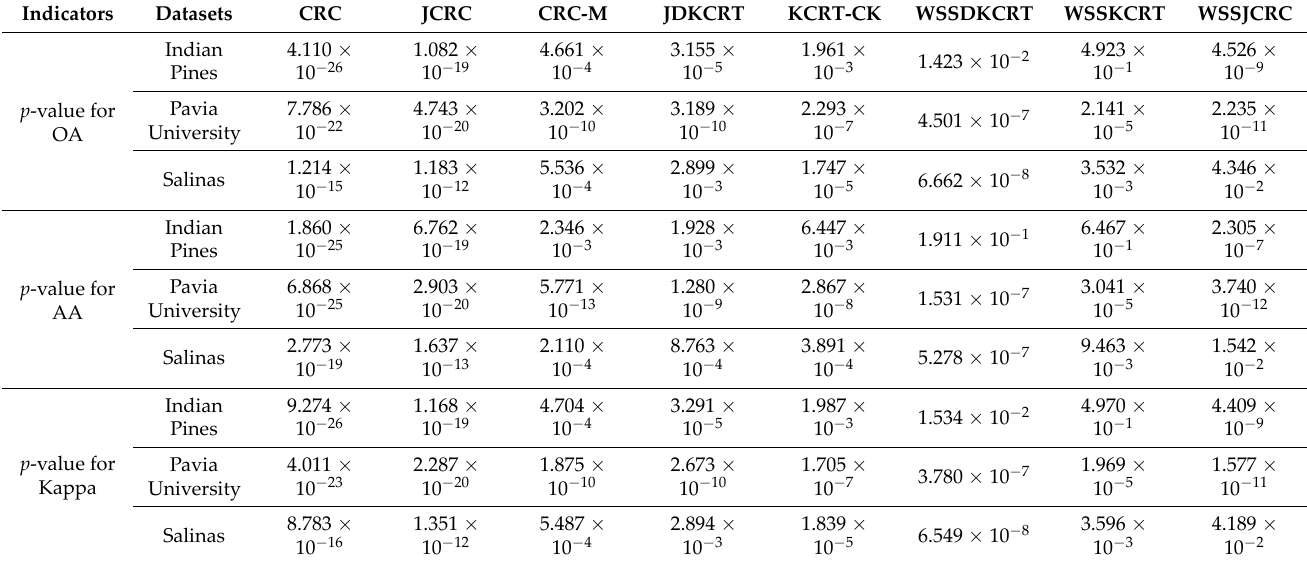
Table 7. Significance analysis of classification performance for the proposed WSSJKCRC method and other methods.